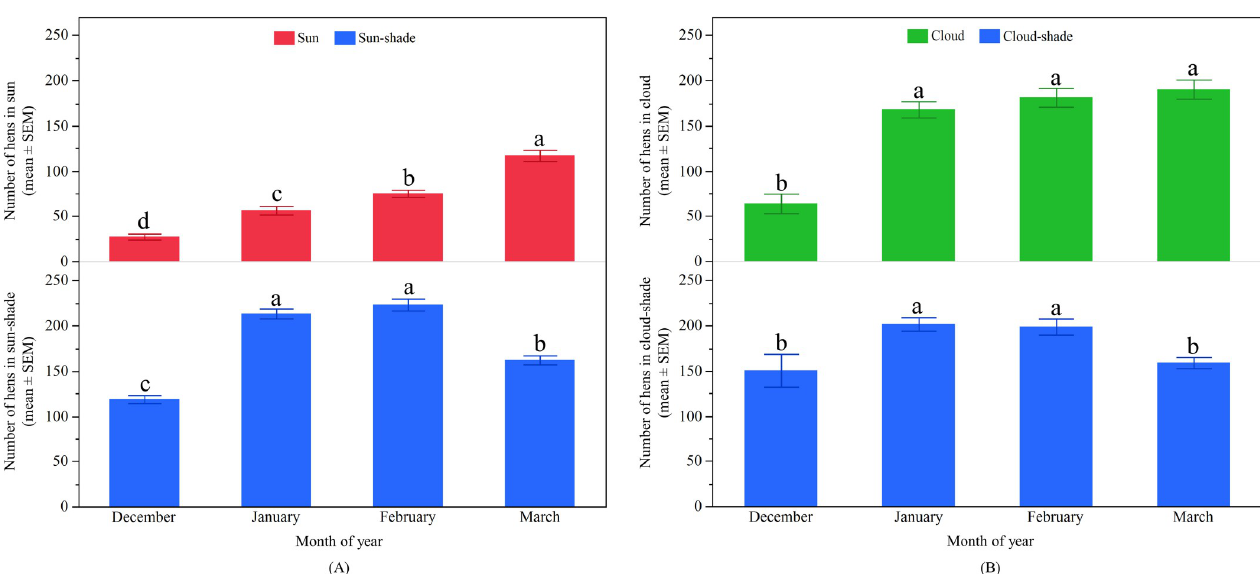
Fig 3. Distribution of hens on the range across months in TAS: (A) The mean ( ± SEM) number of hens in the ‘sun’ (top) and ‘sun-shade’ (bottom); (B) The mean ( ± SEM) number of hens in the ‘cloud’ (top) and ‘cloud-shade’ (bottom). a-d Dissimilar superscript letters indicate significant differences among months. Raw values are presented with analyses conducted on transformed